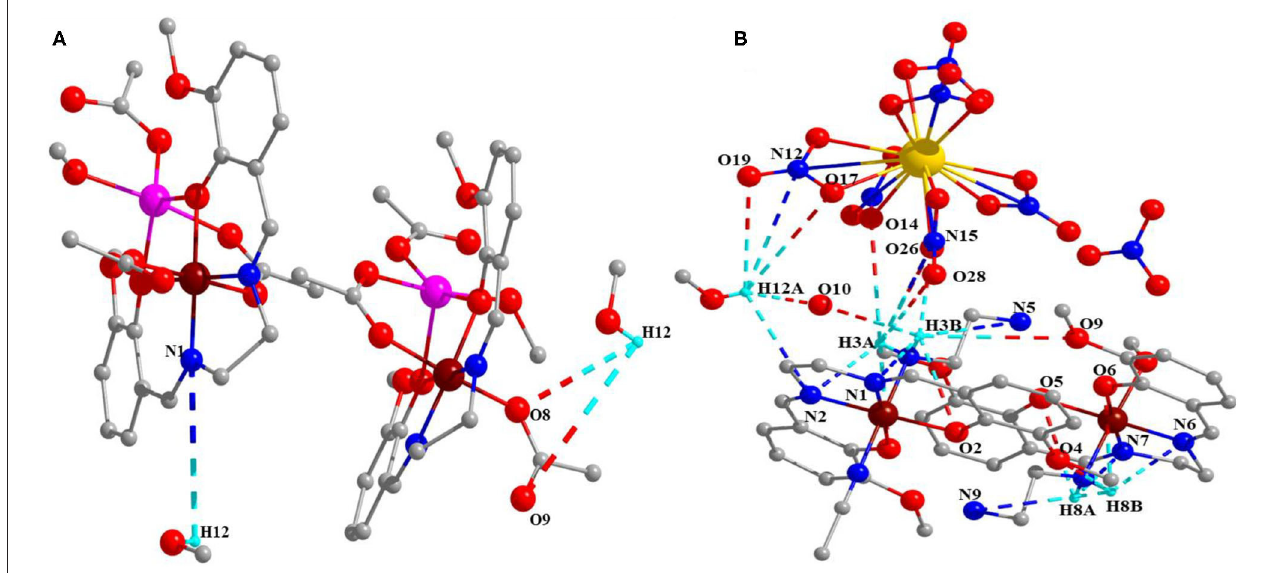
FIGURE 2 | Intramolecular and intermolecular H-bonding (A) complex 1 and (B) complex 2.